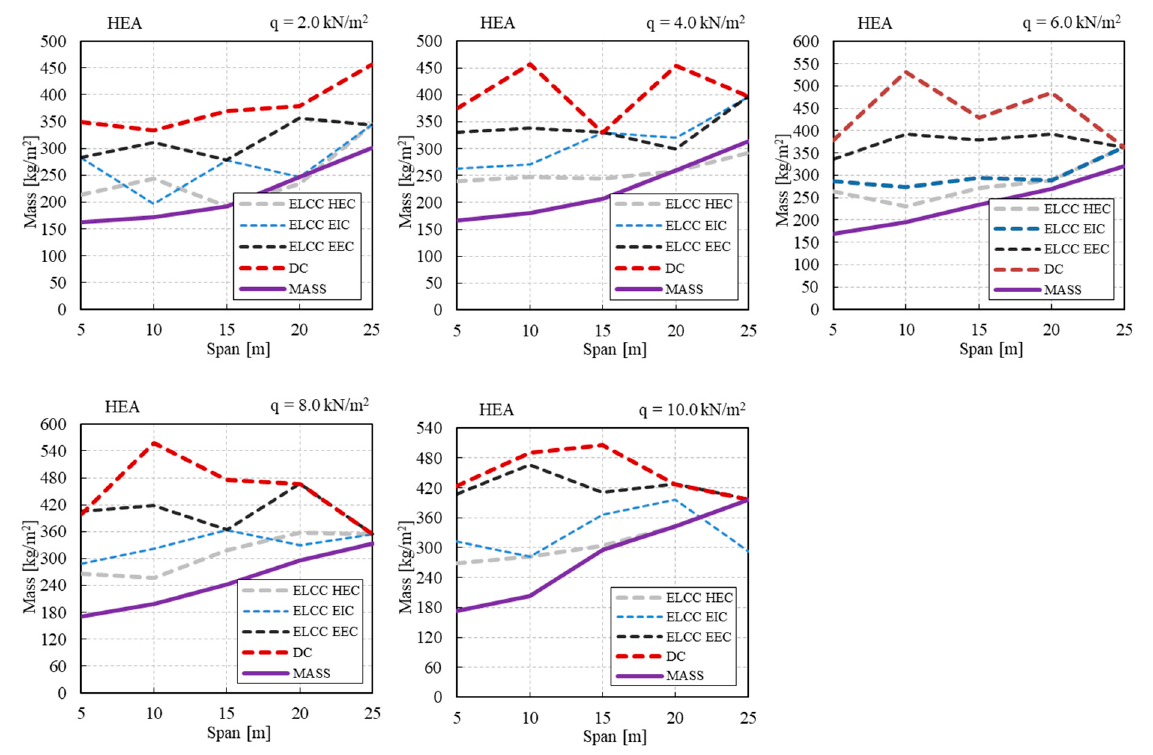
Figure 15. Diagrams of the calculated masses of the CFSHEA structures for different objective functions.